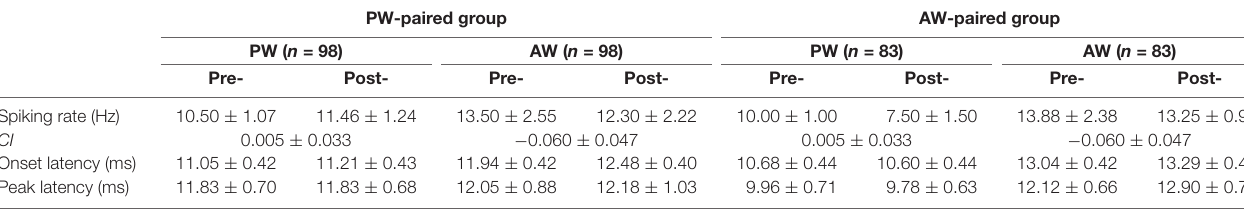
TABLE 1 | Properties of neuronal responses before and after paired stimulation. PW-paired group AW-paired group PW ( n = 98) AW ( n = 98) PW ( n = 83) AW ( n = 83) Pre- Post- Pre- Post- Pre- Post- Pre- Post- Spiking rate (Hz)